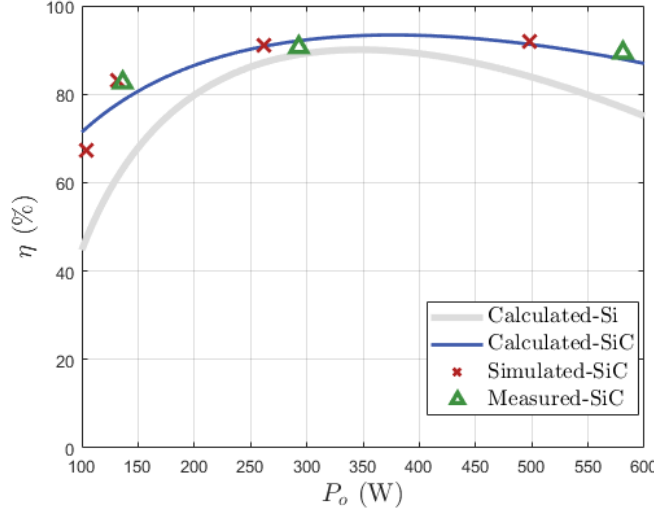
Figure 21. The experimental efficiency of the SiC-based CSI, the efficiency simulated by PLECS, and calculated results of the SiC- and Si-based CSIs.